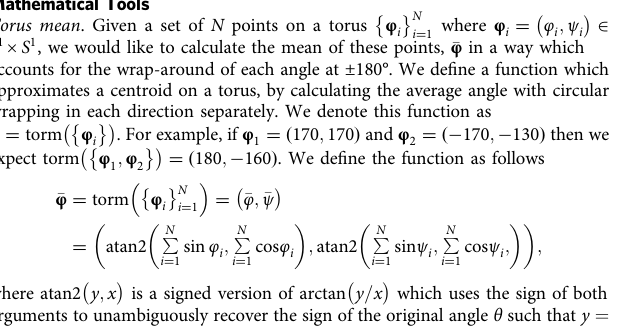
(cid:7) (cid:8) (cid:3) N where φ i ¼ φ i ; ψ i i ¼ 1